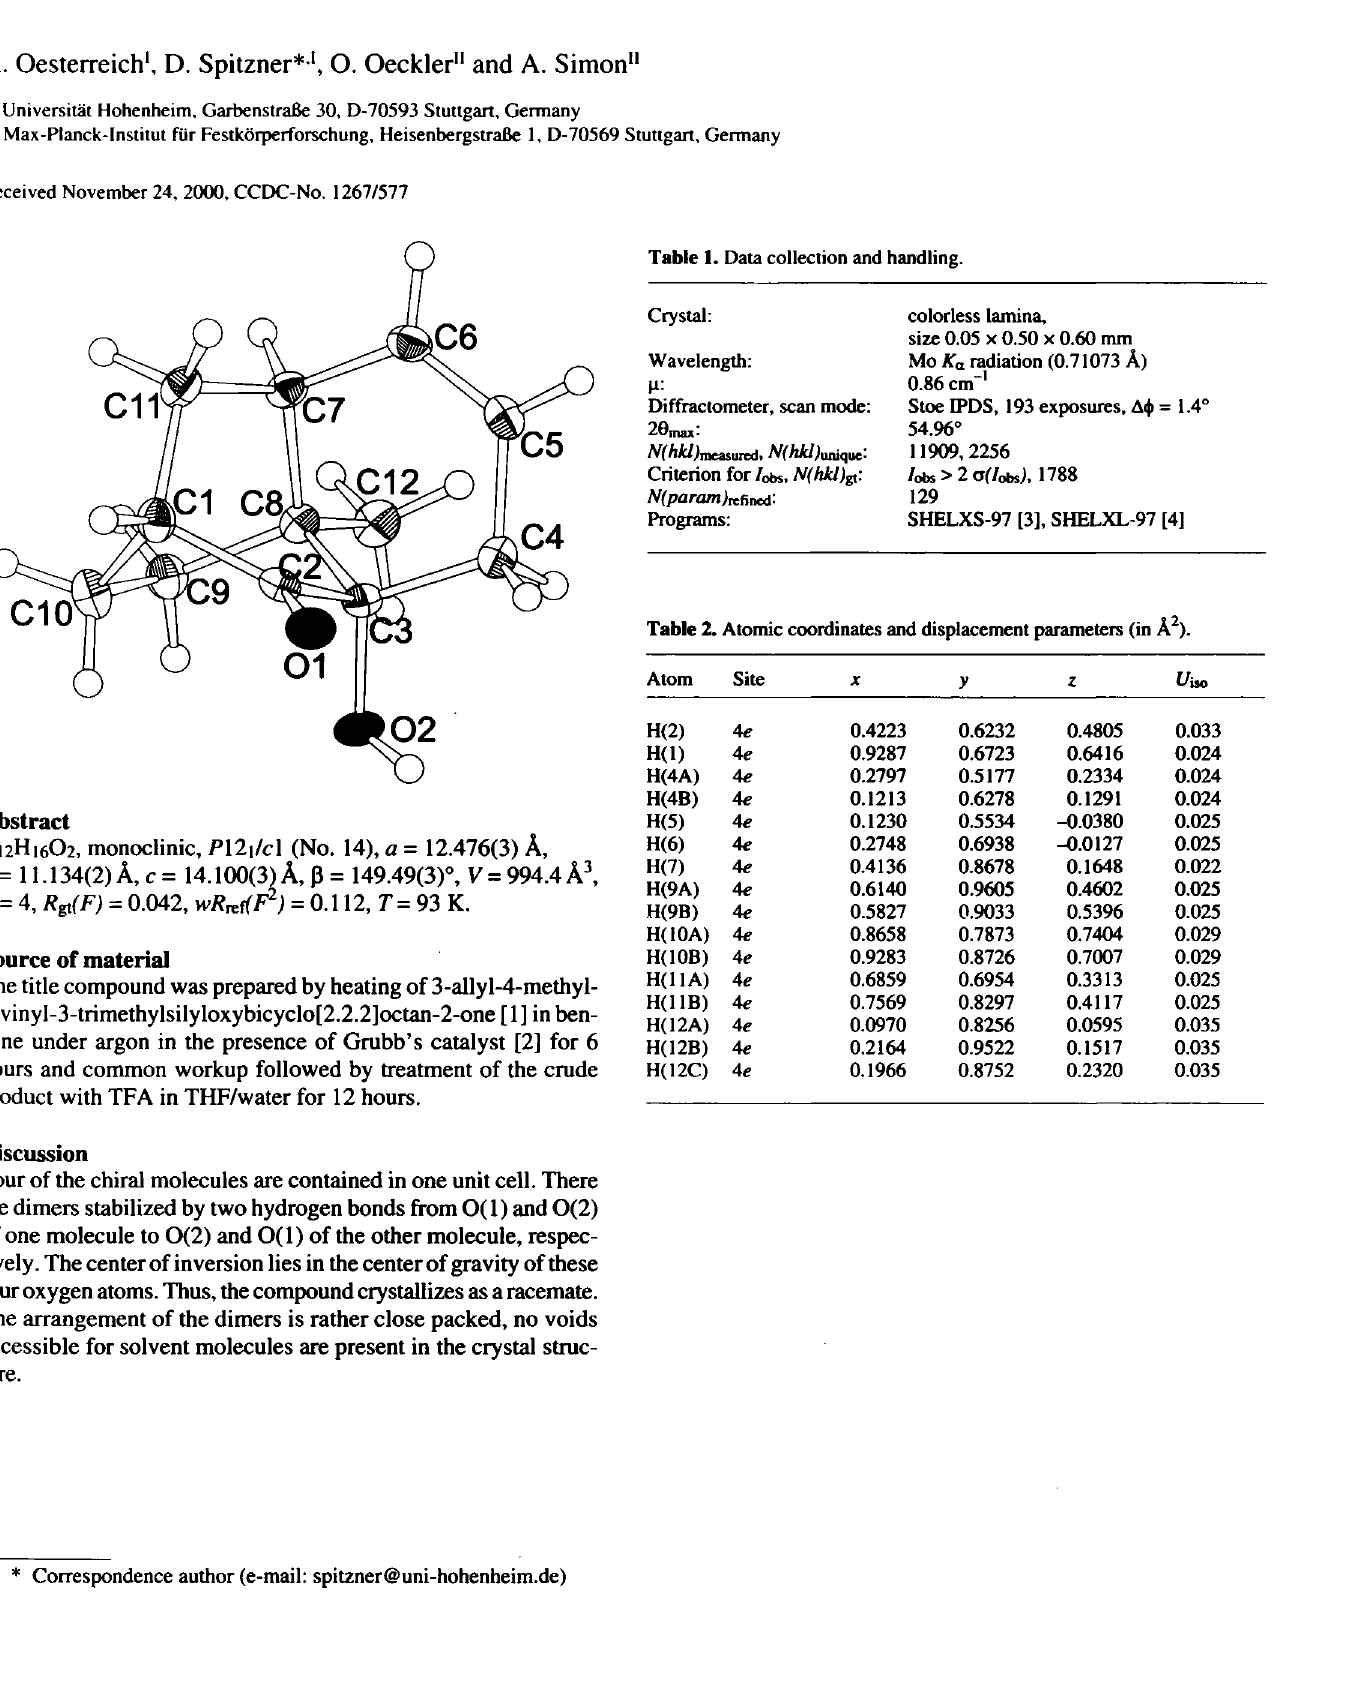
Table 1. Data collection and handling.